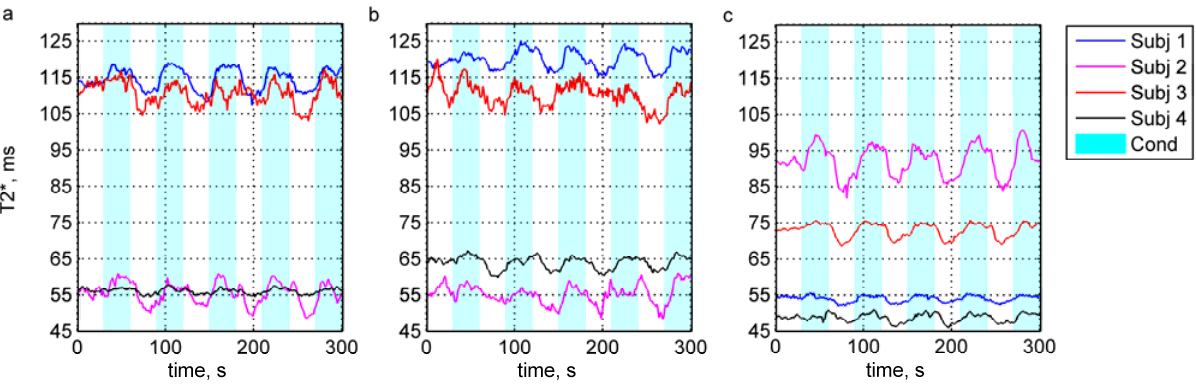
Figure 3. Functional single-voxel proton spectroscopy (fSVPS)-estimated T2* time series. ( a ) The primary motor cortex (PMC); ( b ) PMC in real time (PMC NF); and ( c ) Visual cortex (VC) functional single-voxel proton spectroscopy (fSVPS) time series (processed) are displayed for four control subjects. Acquired time series show significant variability